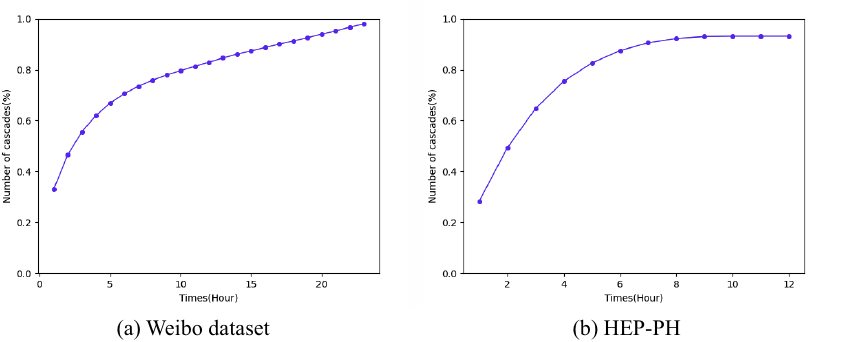
Figure 4. Distribution of popularity: the X axis refers to the cascade size and the Y axis is the number of cascades corresponding to the cascade size.